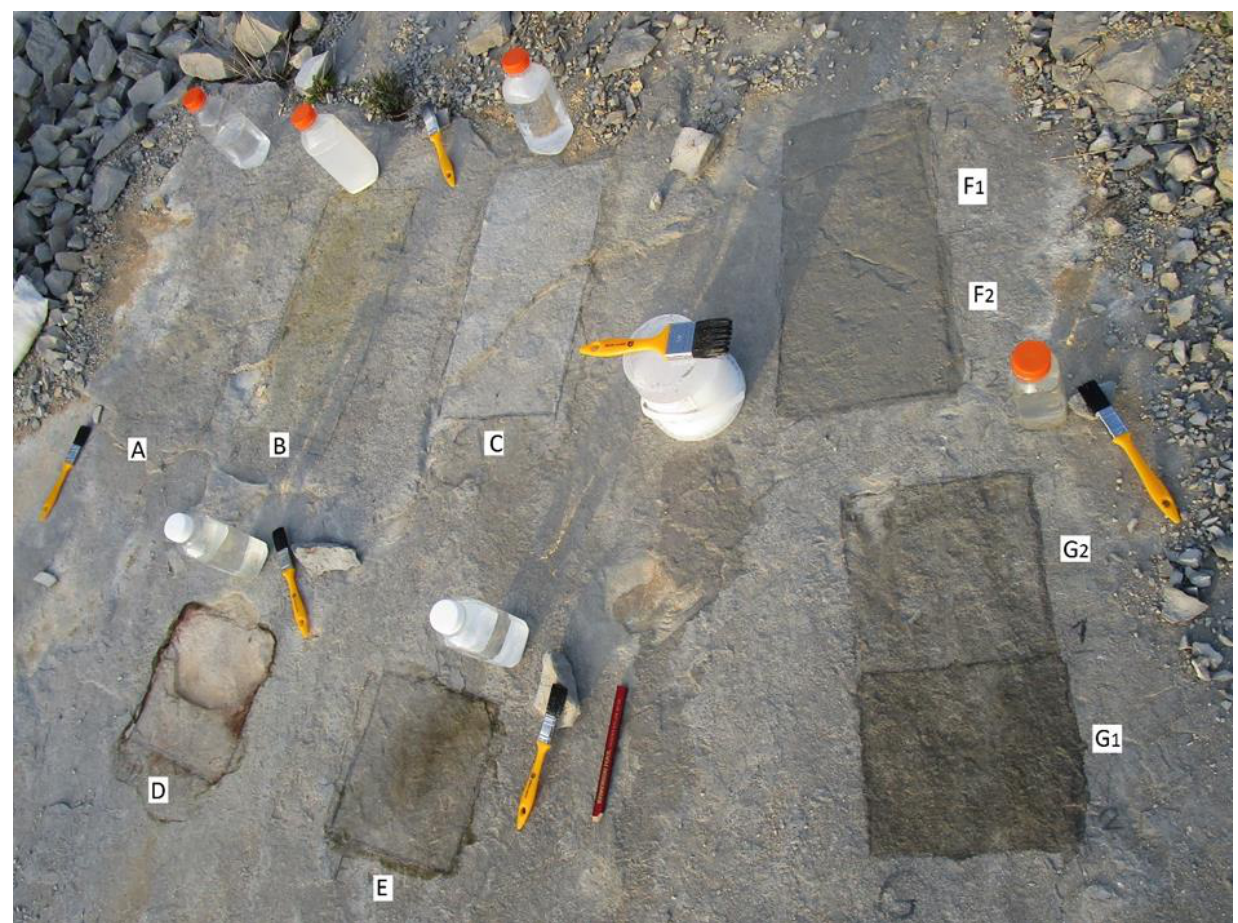
Figure 7. Long-term experiment with application of various products for limestone surface stabilization to weathering in a selected area of Bed 5 bedding plane at Cabeço da Ladeira fossil site: ( A ) lime water (aq.); ( B ) barium hydroxide (aq.); ( C ) ammonium oxalate (aq.); ( D ) solution of barium hydroxide in ethanol; ( E ) ammonium oxalate solution in ethanol; ( F ) nanosilica (upper half — F1 — one coating layer, lower half — F2 — two coating layers); and ( G ) paraloid B-72 solution in ethanol (upper half — G1 — one coating layer, lower half — G2 — two coating layers). Dimensions of the areas where the products were applied: 20 × 40 cm and 20 × 20 cm.